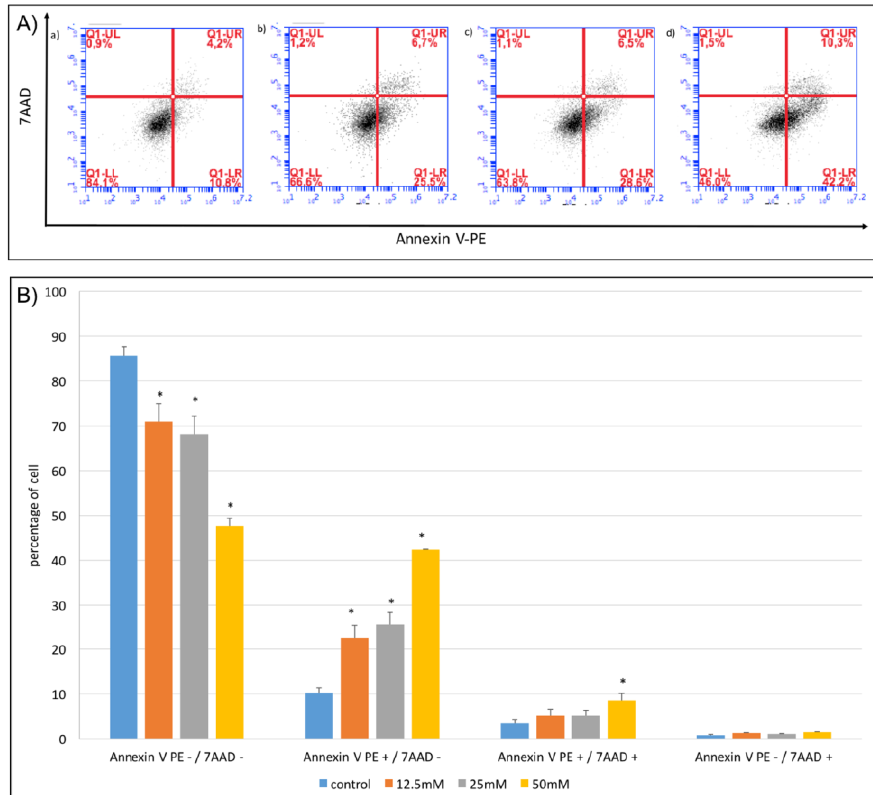
Figure 5. Induction of HCT116 colon cancer cell apoptosis by sodium benzoate. HCT116 colon cancer cells were seeded to six well plates and after overnight incubation, they were treated with 12.5–50 mM concentrations of NaB for 24 h before analysing. ( A ) The representative plots for ( a ) HCT116 cells without treatment, ( b ) HCT116 cells treated with 12.5 mM NaB, ( c ) HCT116 cells treated with 25 mM NaB, and ( d ) HCT116 cells treated with 50 mM NaB. ( B ) Bar graphs for each treatment group stained with Annexin V-PE and 7-AAD before detection with flow cytometry (Accuri C6). PE-/7 AAD- cells represent